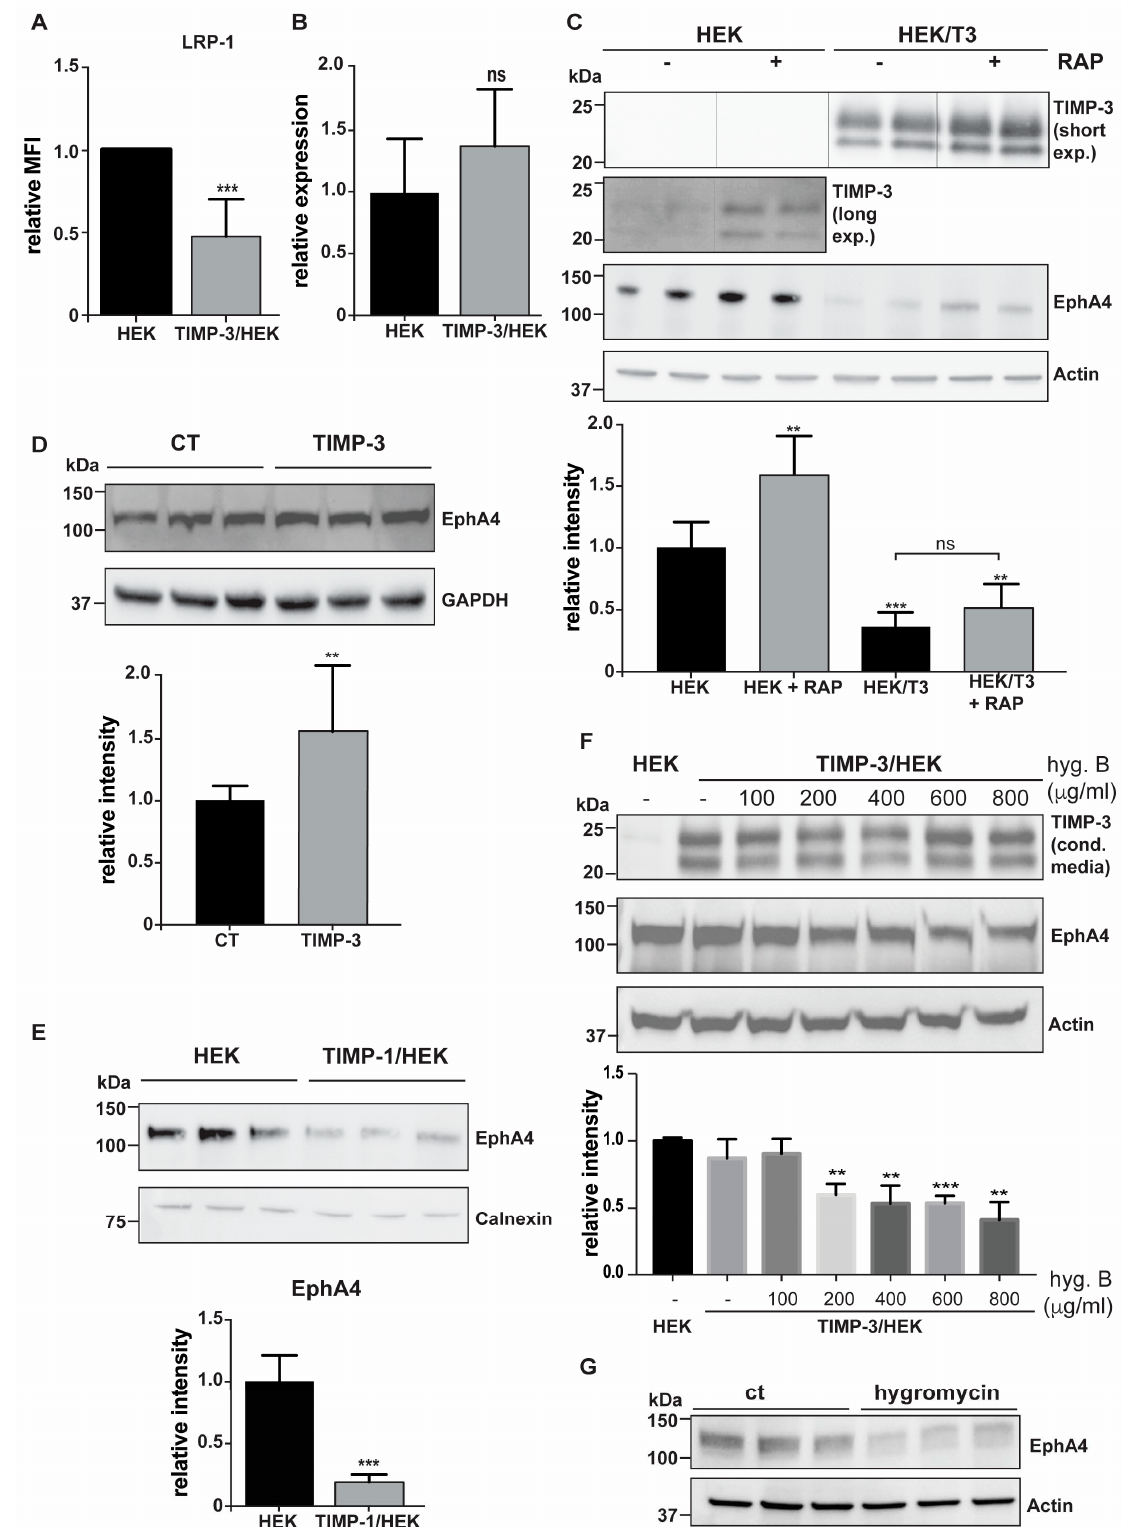
Figure 5. Treatment with hygromycin B of transgenic cells lowers levels of EphA4. ( A ) Levels of LRP-1 on TIMP-3/HEK or control cells was measured by flow cytometry and plotted as the average of mean fluorescent intensities (MFI) ± standard deviation ( n = 3). ( B ) Expression levels of EphA4 mRNA in TIMP-3/HEK and control HEK 293 cells plotted as relative 2 − ∆∆ CT ( n = 4) ( C ) Immunoblots and their respective quantification ( n = 4) showing levels of EphA4 in TIMP-3/HEK or control HEK 293 cell lysates, in the absence or presence of 500 nM RAP. Actin was used as a loading control. ( D )